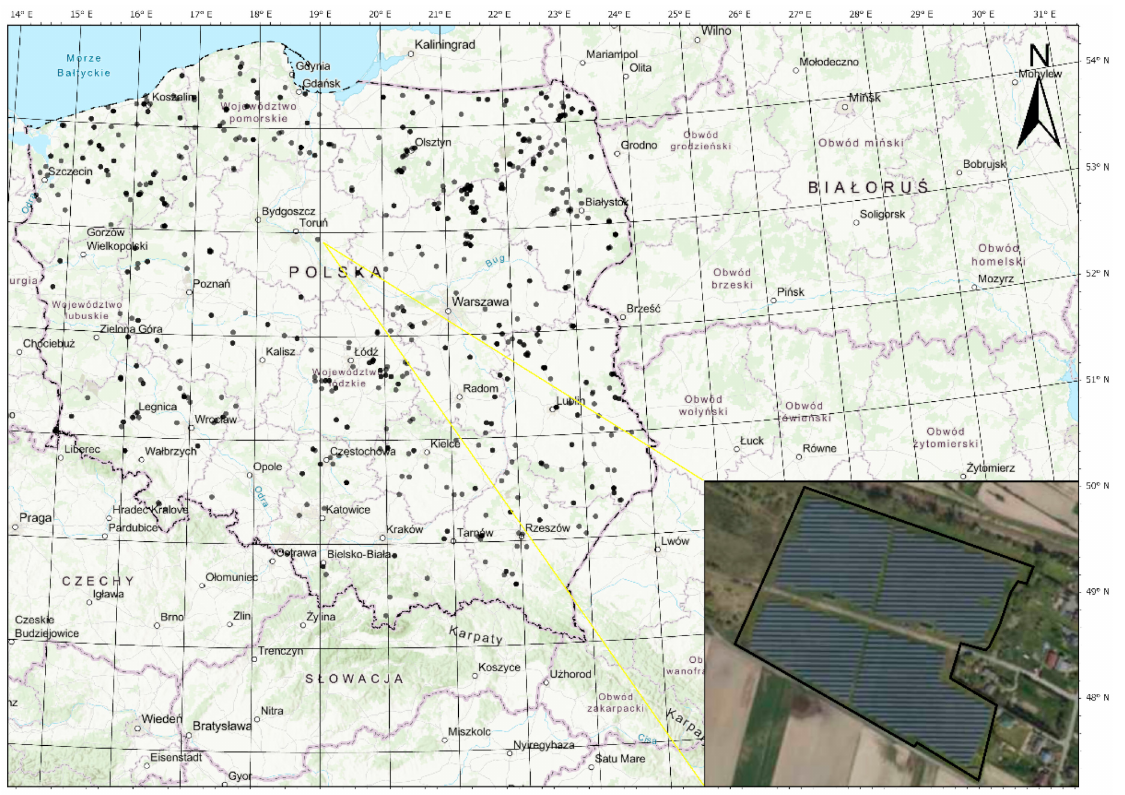
Figure 4. Location of the existing PV farms in